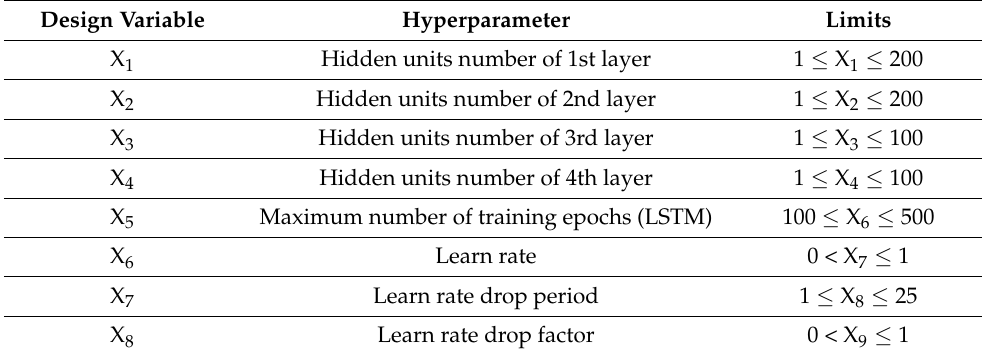
Table 1. Defining hyperparameters of LSTM as design variables of the ELATLBO.